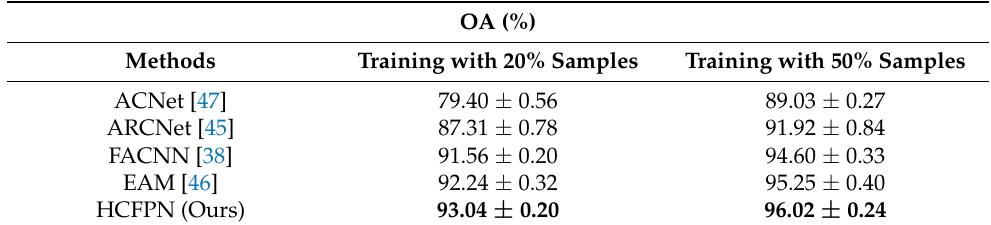
Table 3. Overall accuracy (%) of the HCFPN and the comparison methods when trained on the AID dataset using a proportion of 20% and 50% of the samples.